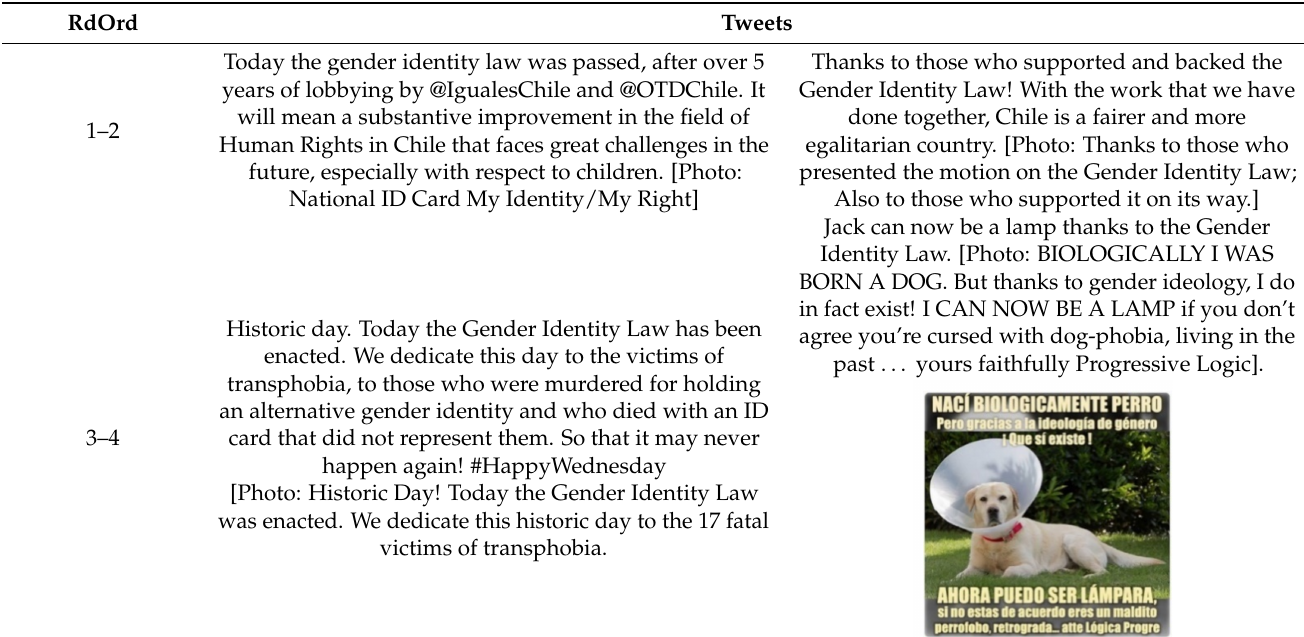
Table 1. Selection of